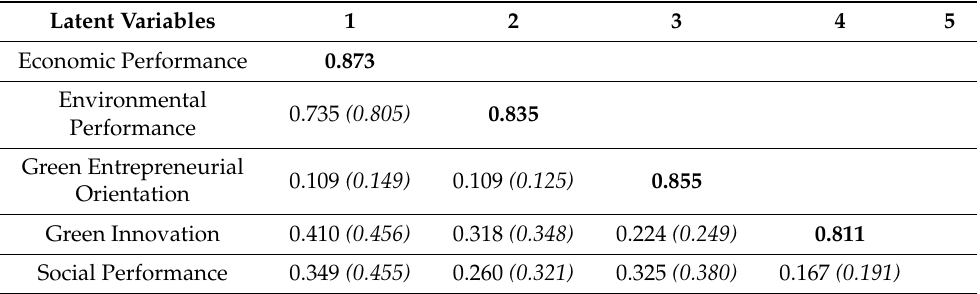
Table 3. Discriminant